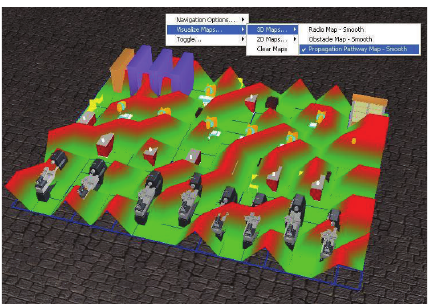
Figure 9: A 3D representation of the detected propagation path- ways, color-coded green, and detected obstacles, color-coded red.